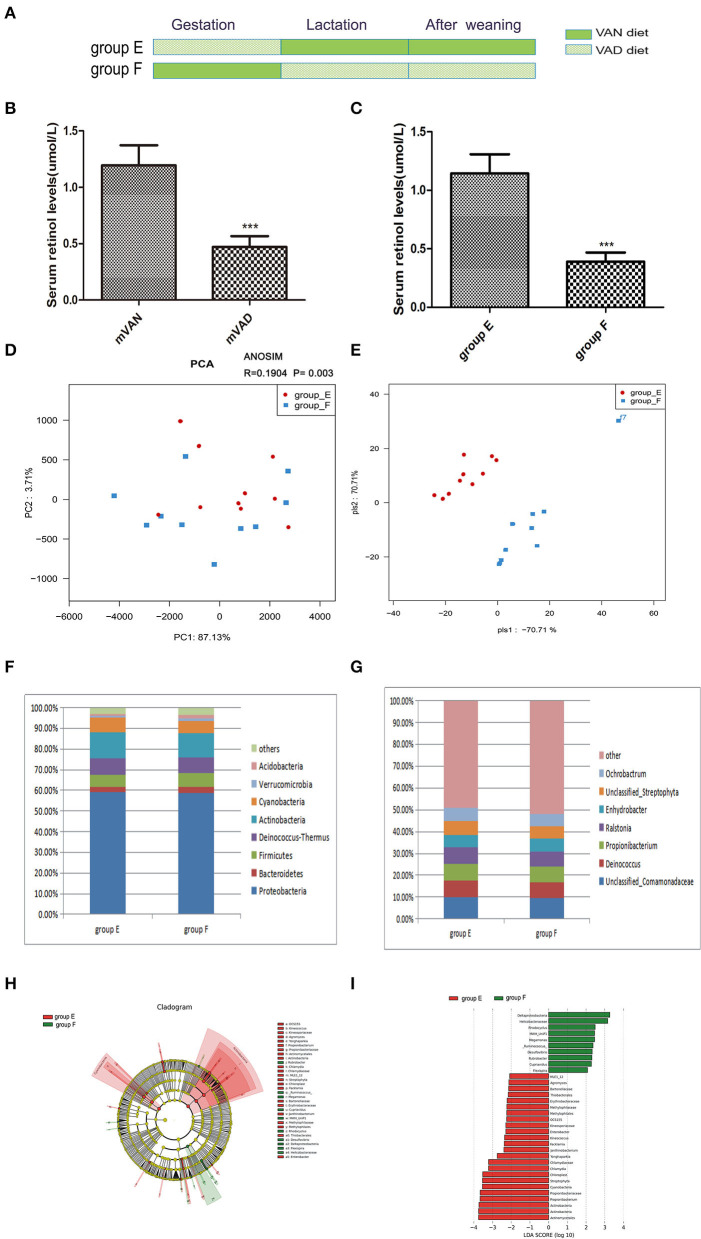
The comparison of colonic mucosal microbiota between the group E and group F. (A) Schematic diagram showing the two offspring groups: group E, group F. The group E pups were cross-fostered to VAN dams during the lactation period and then fed the VAN diet after weaning. The group F pups were cross-fostered to VAD dams during the lactation period and then fed the VAD diet after weaning. (B) The serum retinal levels of maternal rats. Serum VA levels were detected by HPLC. Values represent mean ± SD n = 10 mVAN and 10 mVAD, ***P < 0.001 by Student's t-test. (C) The serum retinal levels of offspring at 6 weeks old. Serum VA levels were detected by HPLC. Values represent mean ± SD n = 10 group E and 10 group F, ***P < 0.001 by Student's t-test. (D,E) The PCA and PLS-DA analysis of the samples between the group E and group F. (D) PCA scores were plotted based on the relative abundance of OTUs (n = 10). (E) PLS-DA was plotted based on the unweighted UniFrac distance metrics (n = 10). The red circles represent for the group E, blue squares for the group F. (F) The phylum level of dominant bacteria with relative abundance more than 1% in the two groups. (G) The genus level of dominant bacteria with relative abundance more than 5% in the two groups. (H,I) Different structures of colonic mucosal microbiota in rats with VAN or VAD diet by LEfSe analysis. (H) A cladogram of the statistical and biological differences in the colonic microbiota between the group E and group F, which are shown by the color of the most abundant phylotypes (red indicating group E, green group F, and yellow non-significant) (n = 10). (I) A histogram of the LDA scores for the most abundant phylotypes (n = 10).